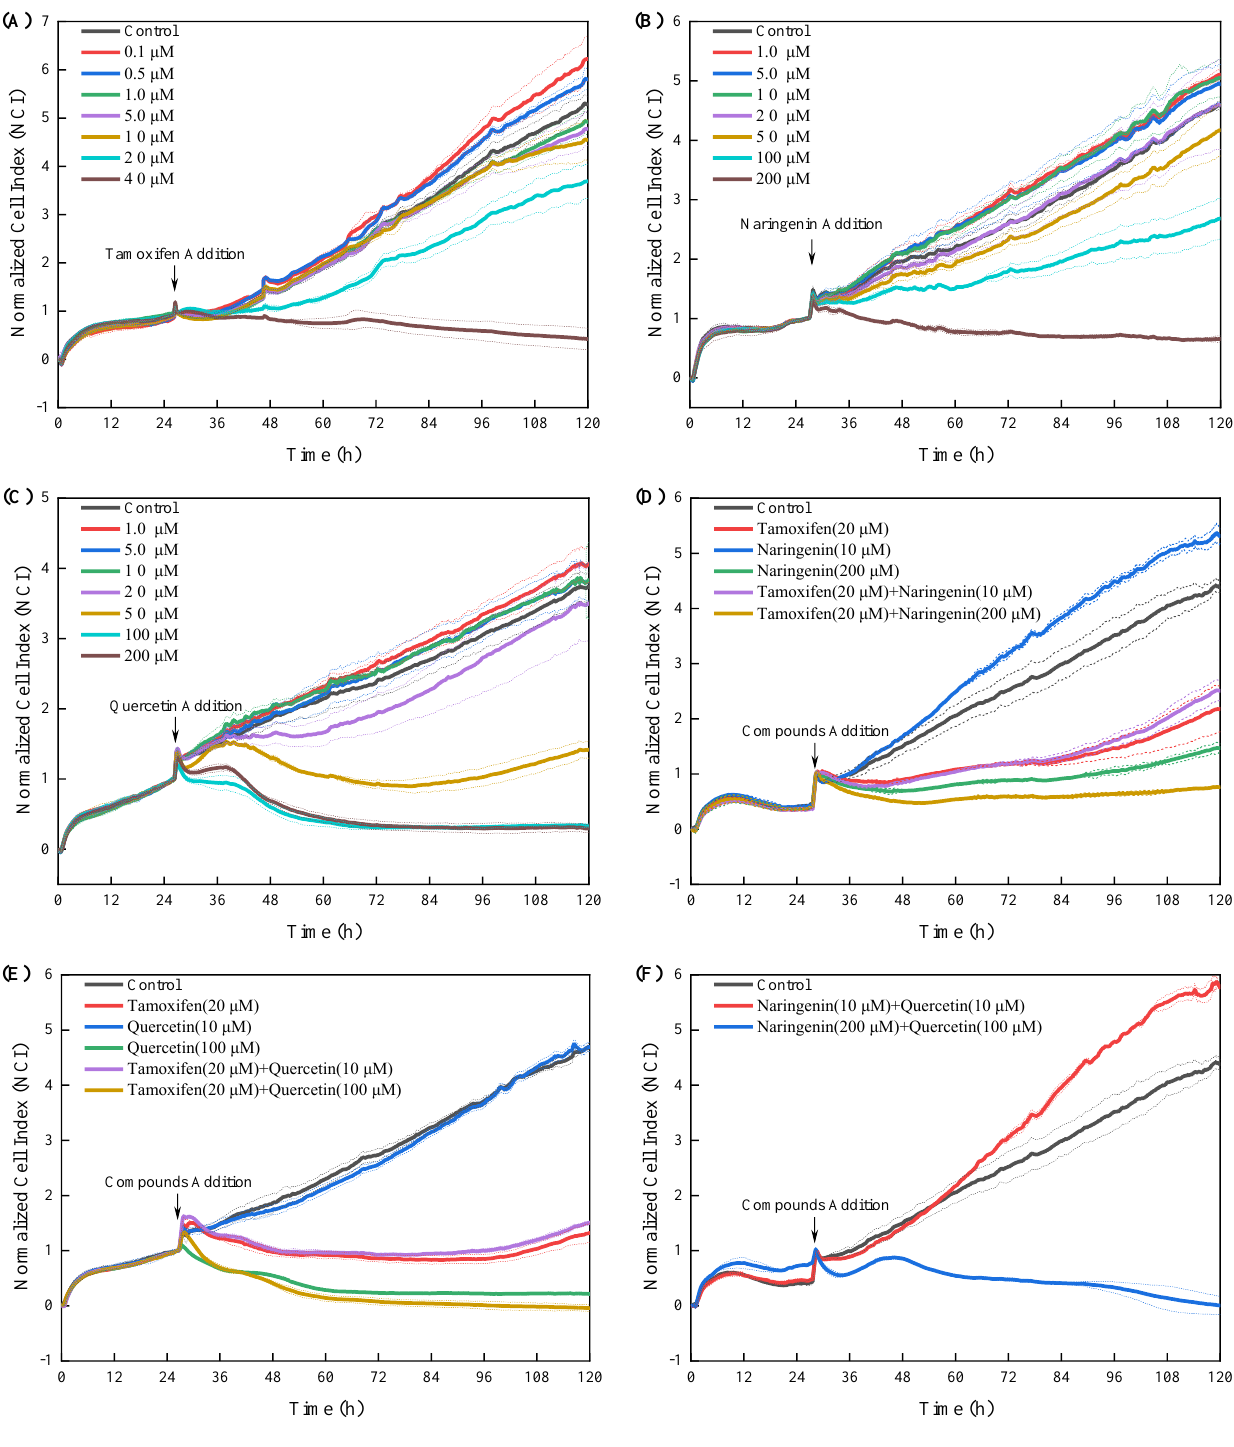
Figure 2. Effects of increasing concentrations of tamoxifen, naringenin and quercetin or their com- bined treatment on cell proliferation and cytotoxicity using RTCA assay. Cells were exposed to tamoxifen ( A ), naringenin ( B ) and quercetin ( C ) either alone or in combination ( D – F ) for up to 96 h, and the normalized cell index (NCI) was determined using real-time cellular impedance analysis monitoring equipment (xCELLigence RTCA S16) according to the manufacturer instructions. Results are expressed as mean ± SD of three independent experiments ( n = 2).